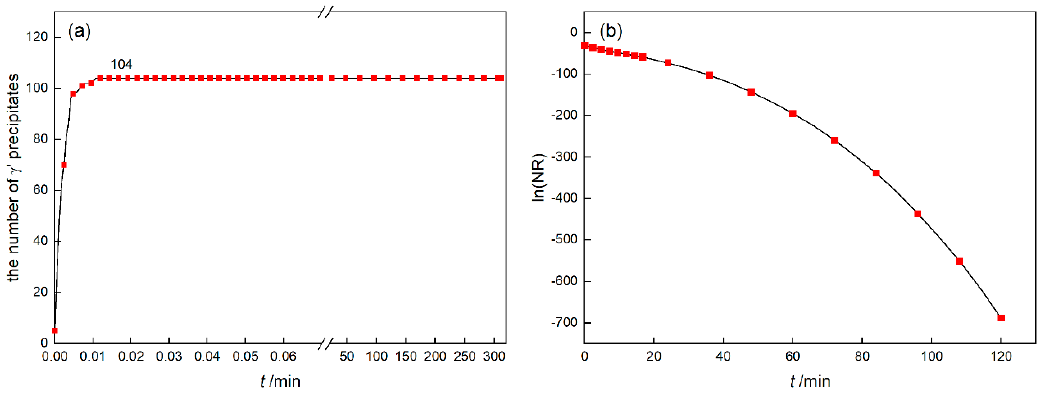
Figure 5. The number of γ precipitates ( a ) and the average nucleation rate ( b ) of DD6 at 1120 C.